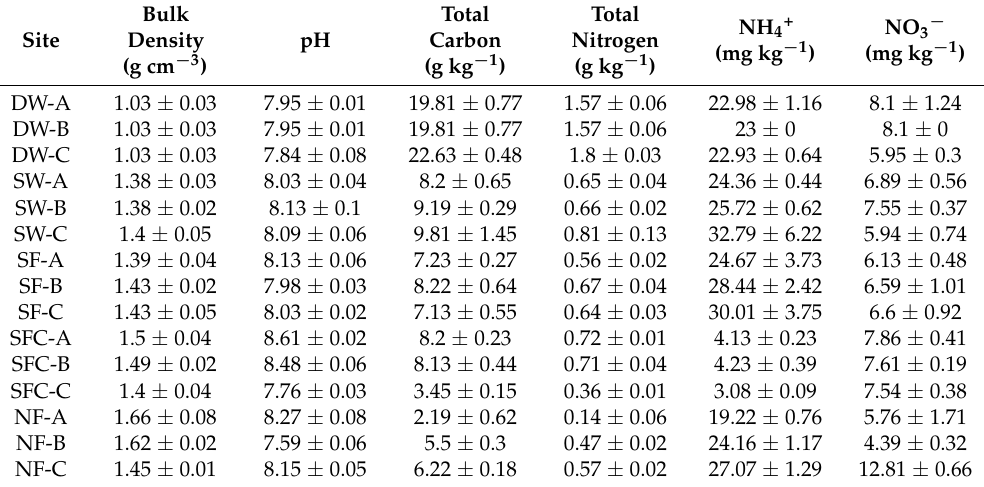
(November 2011, May, July, August, September and October 2012) and covering the transition in and